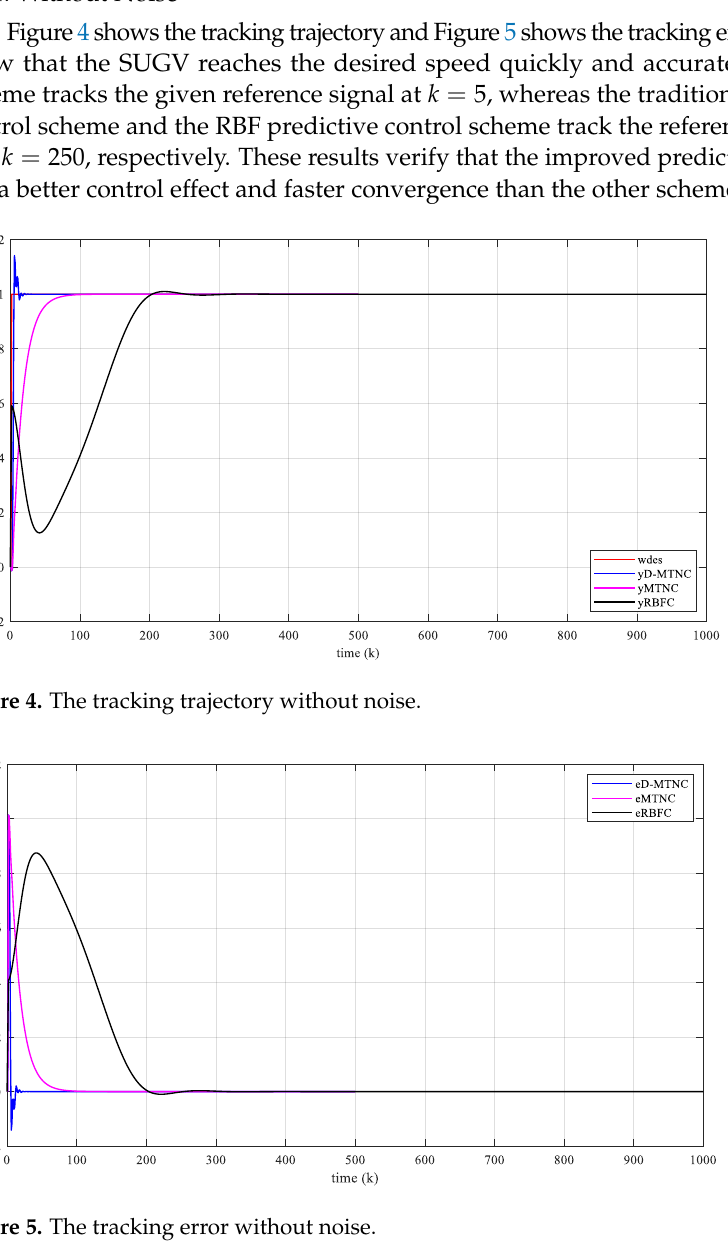
Figure 5. The tracking error without noise.